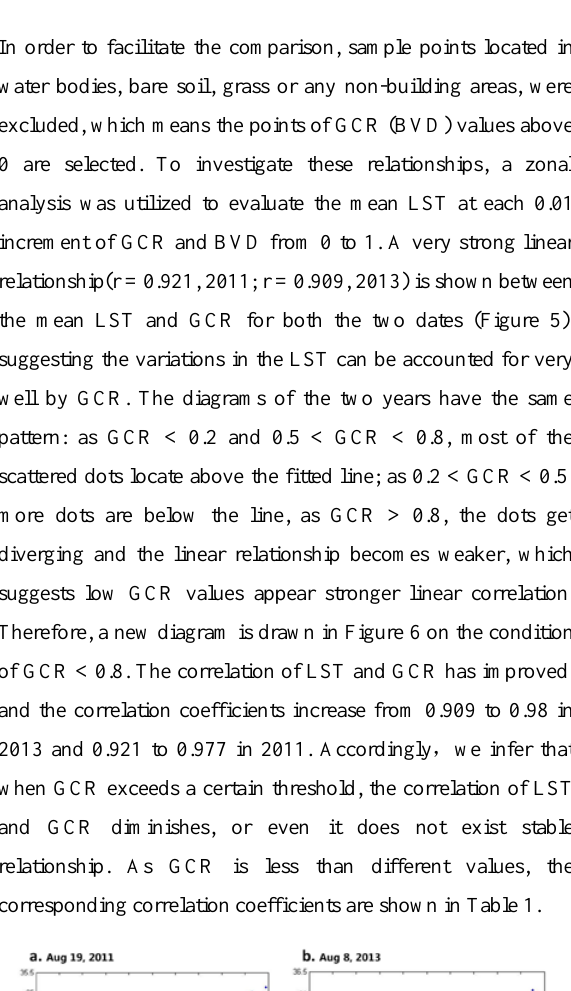
Figure 3. GCR images with the cell size of 60 meters derived from building census data of 2011 and 2013